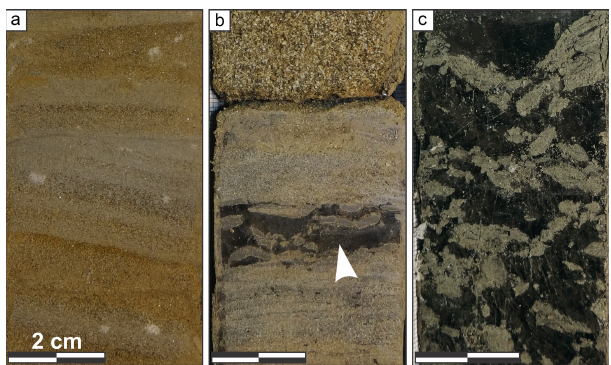
Figure 6. Cryofacies. (a) Pore (Po) cryofacies. (b) Layered (La) cryofacies indicated by the white arrow. (c) Suspended (Su) cryofa- cies. Note the ice appears black in the